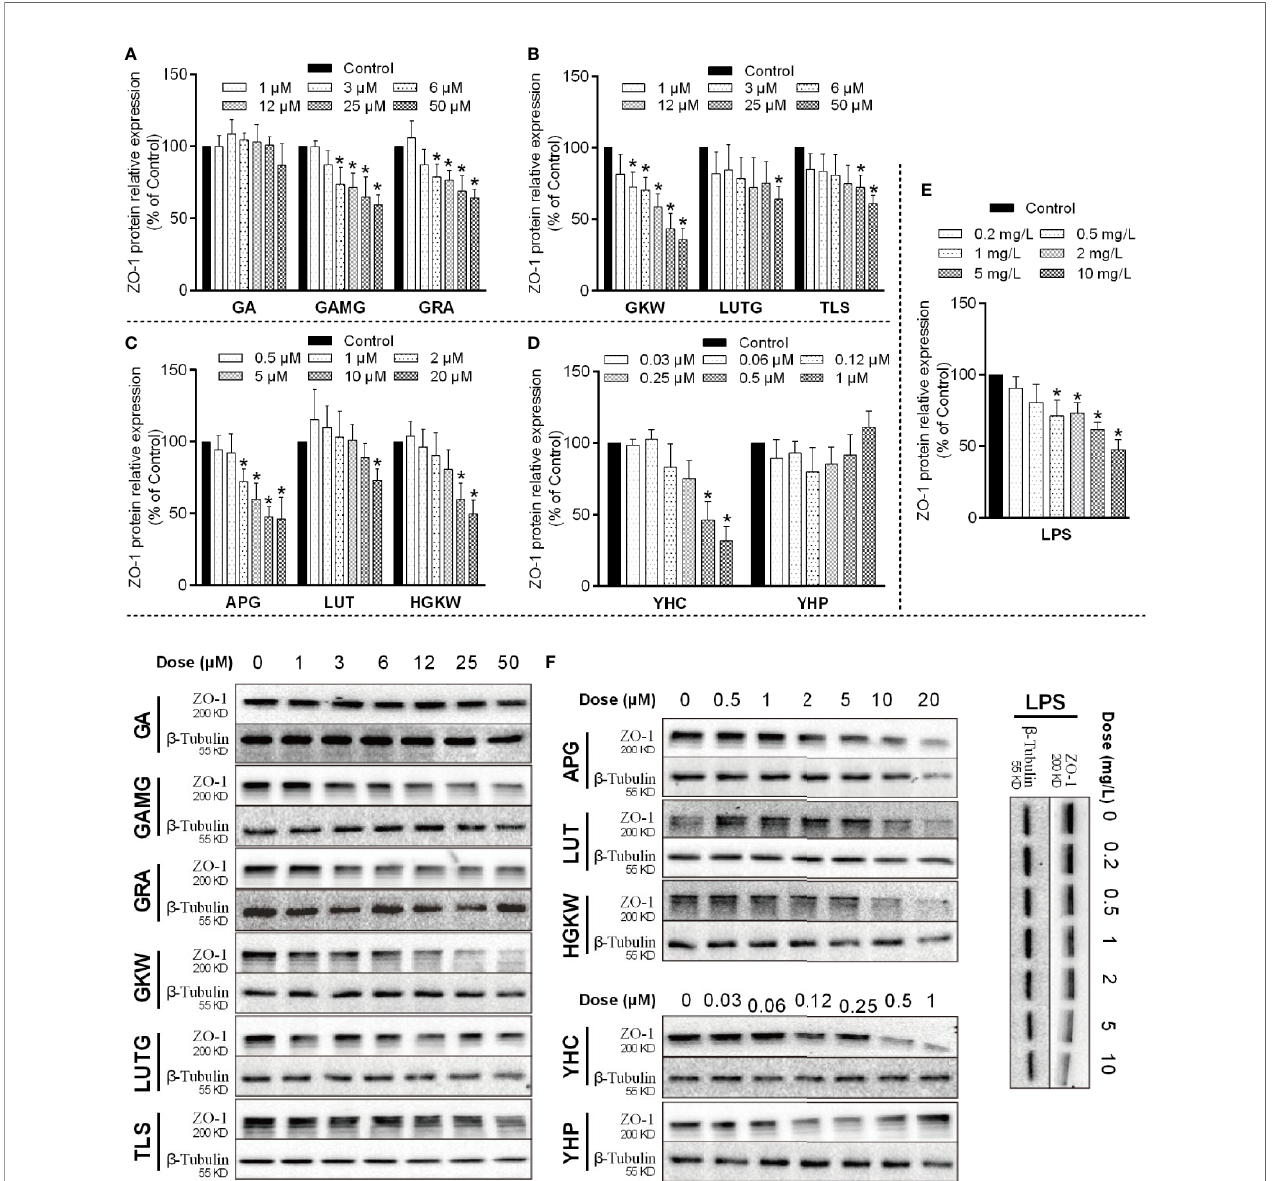
FIGURE 9 | ZO-1 expressions in fl uenced by saponins, fl avonoids, and di-terpenes in IEC-6 cells. (A – E) Bar chart of ZO-1 expressions in IEC-6 cells treated with the indicated compounds. *P < 0.05 compared with control group. (F) Blotting images of ZO-1 expressions in IEC-6 cells treated with the indicated compounds. LPS is used as positive material, and b -tubulin is used as internal